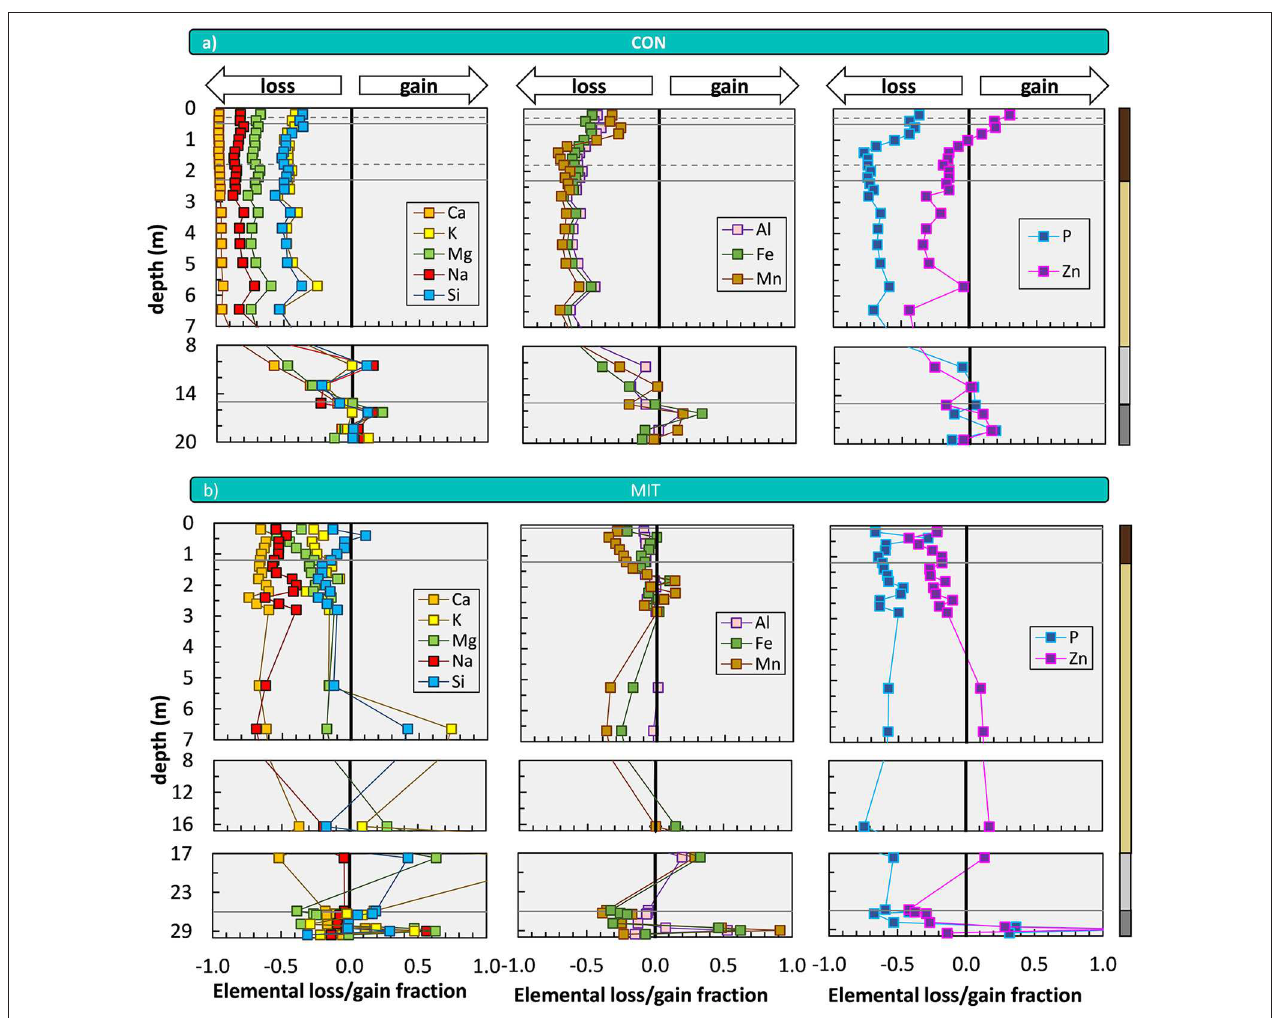
FIGURE 4 | Depth distribution of elemental loss/gain fractions (mass transfer coefficients, τ X Xi ) at CON (a) and MIT (b) . The vertical line indicates a τ X Xi -value of zero and represents unweathered parent bedrock. Solid horizontal lines illustrate soil horizon boundaries and the interface of weathered rock to unweathered rock. Dashed horizontal lines indicate soil horizon subdivision (see Figure 2 ). Colored bars at the right site of panel a refer to color coding of drill core sections from Figure 2 . For ease of display we changed the y-axis spacing with depth, yet all data are shown continuously. X-axis scale in panel a (not shown) is the same as in panel b. Given that some outliers were excluded from this figure, Figure 3a and from flux estimates that are based on τ X Xi , we show the depth distribution of element concentrations in Supplementary Figure 2 , and τ X Xi in Supplementary Figure 3 and Supplementary Figure 4 [according to Fisher et al. (2017) log10 (C X /C j )] including the